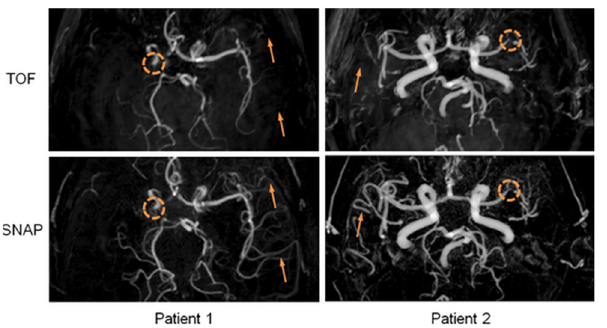
Fig 3. Visual comparison between SNAP and TOF MRA on the same subjects. SNAP and TOF make same detection on stenotic lesions on both subjects (dotted circles). The small artery visualization on SNAP MRA is significantly improved